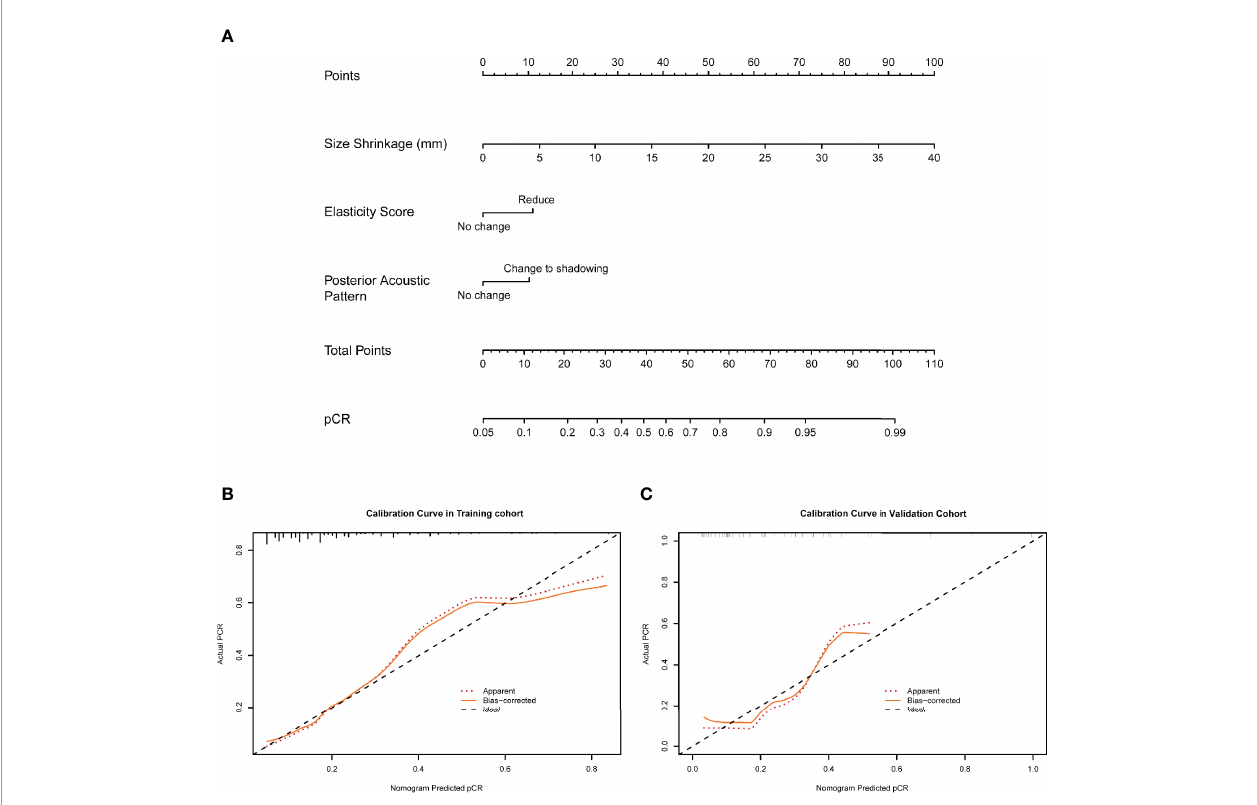
FIGURE 4 | (A) A two-cycle response nomogram including early response to chemotherapy was constructed from three informative features ( Table 2 ). When the total points reach 100, the probability of achieving pCR reached 99%, which mean that the prediction ef fi ciency was satisfactory (B, C) . pCR, pathological complete